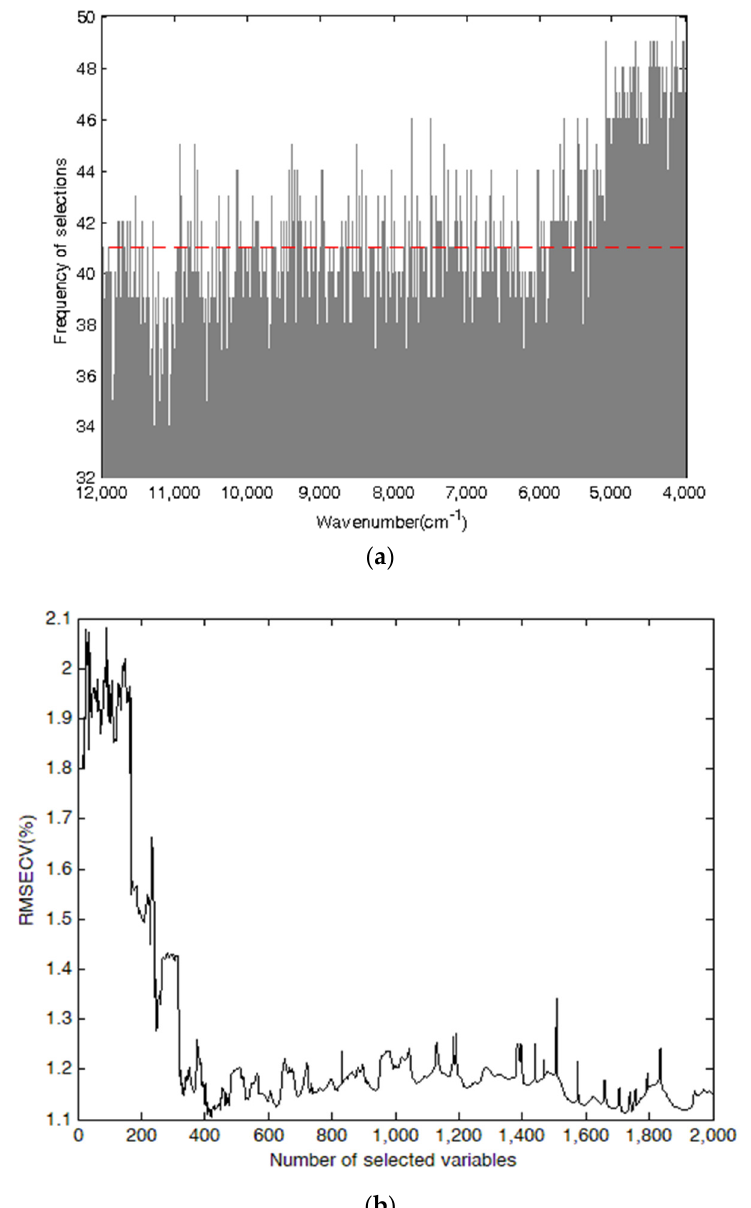
Figure 5. Plots of characteristic variable selection based on GA for cellulose in Sargassum horneri. Plots ( a ) and ( b ) show the variable frequency and RMSECV value, respectively.